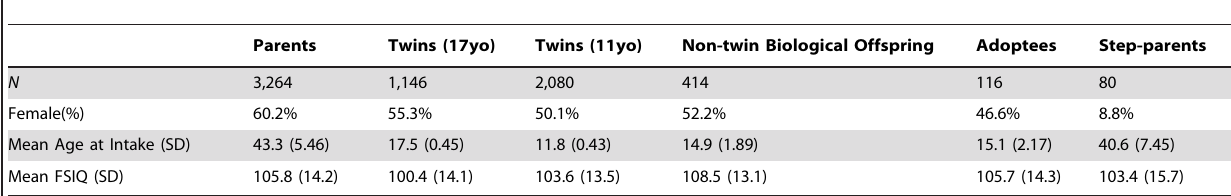
Table notes: Total N =7100, in 2376 families. FSIQ=Full-Scale IQ; 17yo=17-year-old cohort; 11yo=11-year-old cohort. For a minority of twins (38%), FSIQ represents a within-person average of FSIQ scores from more than one assessment (see text). FSIQ range: 151–59=92. Parental intake age range: 65–28=37. Offspring intake age range: 20–10=10.